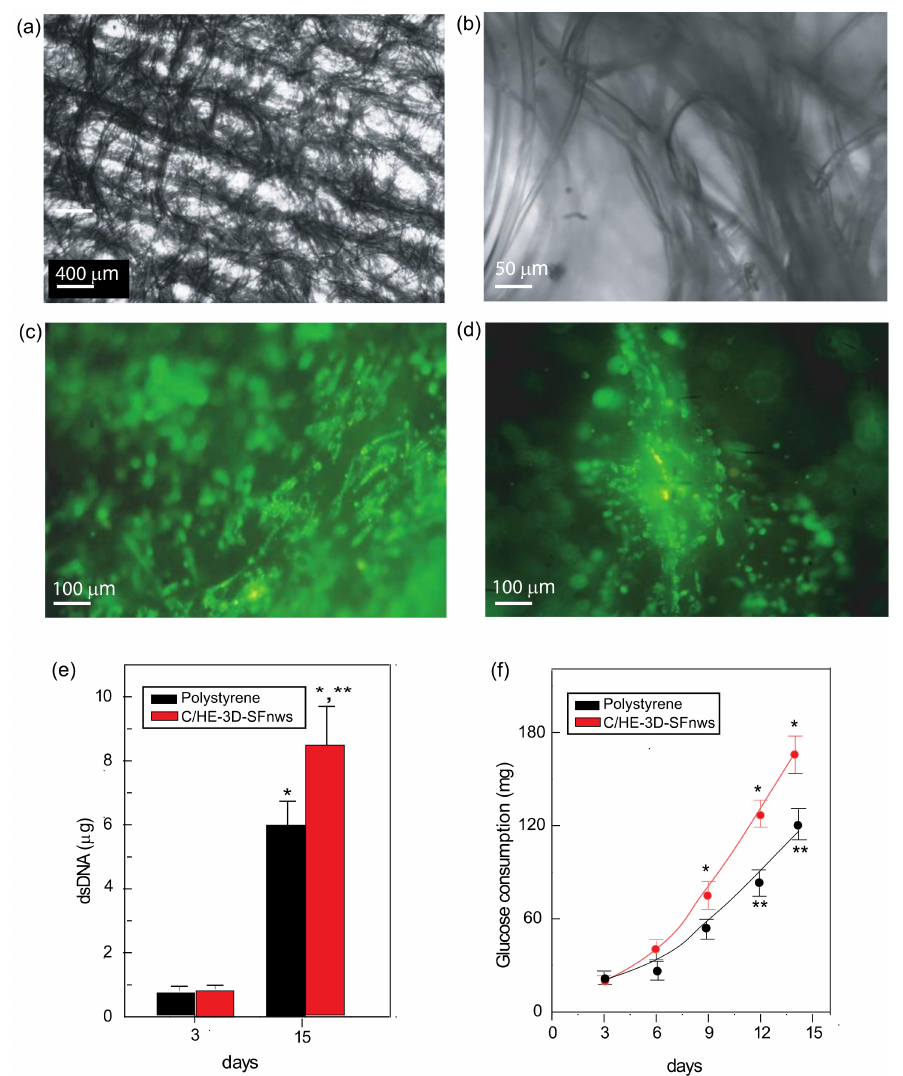
Figure 1. Three-dimensional SF nonwovens (C/HE-3D-SFnws) produced via the carding/ hydroentanglement technology are scaffolds supporting the growth of AHSMCs. ( a , b ) In these cell-free C/HE-3D-SFnws fabrics the SF microfibers form thick longitudinal bundles along the carding machine direction joined by transversal bridges created by the hydroentanglement technology. Light microscope; at low (50 × ; a ), and high (500 × ; b ) magnifications. ( c , d ) Five days after seeding intravitally prestained AHSMCs have adhered along an SF microfiber bundle and have also started colonizing the nearby intercalated voids. ( e ) AHSMCs attached to 3D-SFnws intensely grew between 3 and 15 days of staying in vitro as shown by their 10.9-fold increase in number, while the polystyrene-stuck AHSMCs rose by 7.8-fold. Double strand (ds)DNA amounts were assayed as detailed in the Section 2.5 Bars are mean values ± standard deviations (SDs) from three distinct duplicate determinations at each time point. *, p < 0.05 vs. day 3; **, p < 0.05 between the two groups at day 15. ( f ) The cumulative D -glucose consumption of AHSMCs. Between day 3 and 15, its uptake from the growth medium on the part of C/HE-3D-SFnws-bound AHSMCs increased by 8.4-fold vs. the 6.1-fold of polystyrene-attached AHSMCs. D -glucose levels of the AHSMC-conditioned media at each time point were assayed as detailed in the Section 2.6. Each dot stands for the mean value ± SDs from three distinct duplicate determinations. *, p < 0.05, vs. day 3 values; **, p < 0.05 between the time-corresponding values of the two